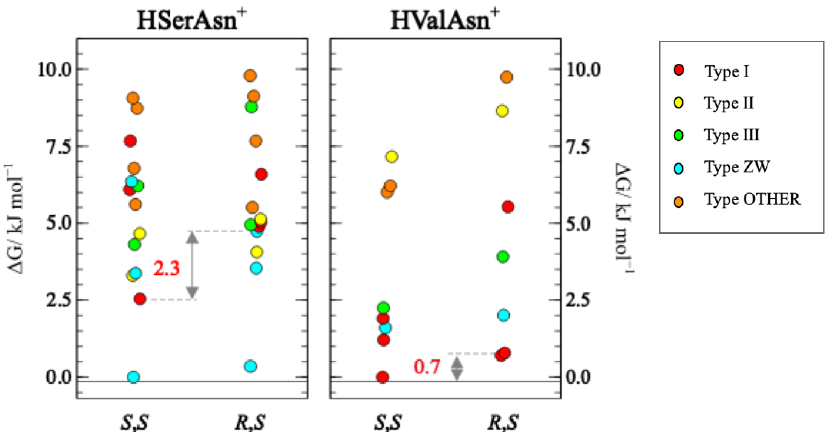
Figure 5. The relative free energies of the four dimer species. The energy gap between the experimentally observed homo- and heterochiral dimers of HSerAsn + is 2.3 kJ mol − 1 and that of HValAsn + is 0.7 kJ mol − 1 .